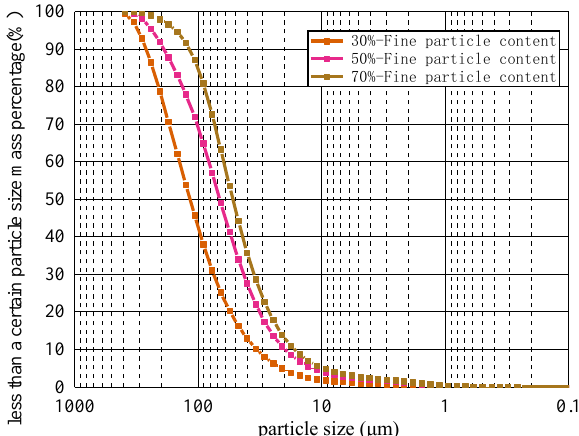
Figure 1. Gradation curve of tailings sand.